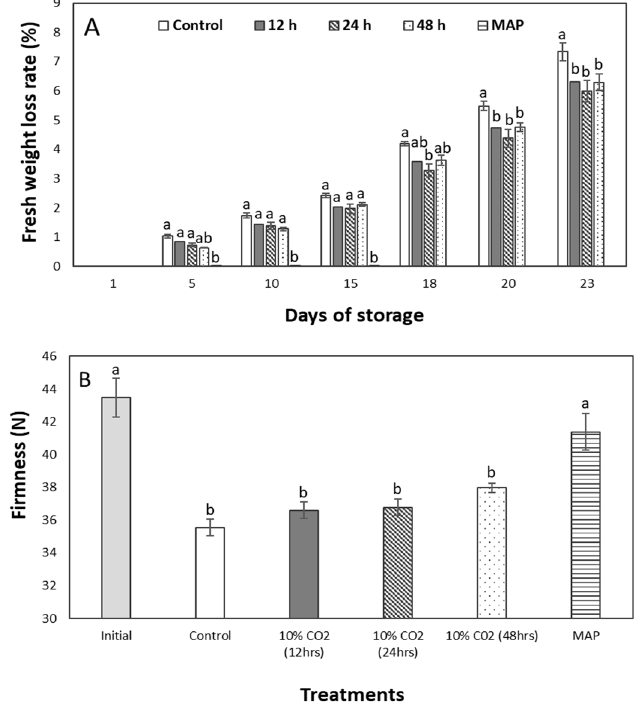
Figure 1. Changes in weight loss ( A ) and firmness ( B ) of sweet peppers pretreated with 10% CO 2 for 12, 24, and 48 h, as well as untreated and modified atmosphere packaging (MAP) with 50,000 cc ∙ m –2 ∙ day –1 ∙ atm –1 OTR film throughout the 15 days of cold storage and 8 days at room temperature. The vertical bars represent ± SE of n = 4, and different letters indicate a significant difference at p < 0.05.